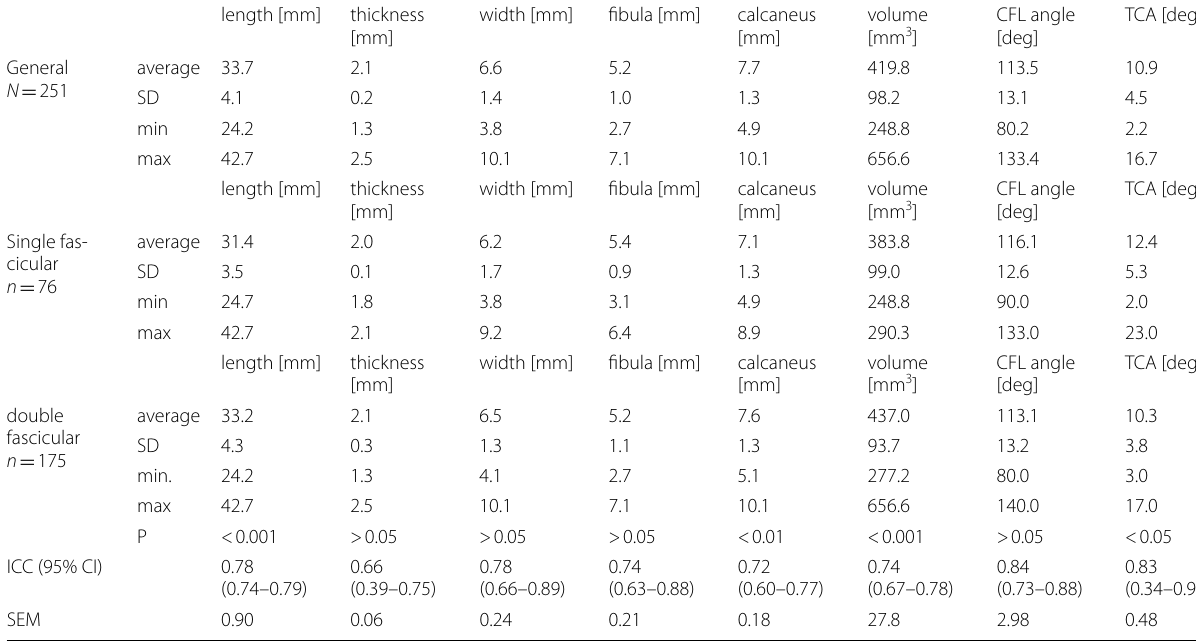
Table 4 Dimensions of the calcaneofibular ligament in the general group, single fascicular and double fascicular ligaments